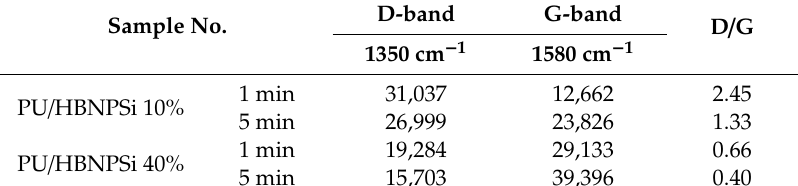
Table 3. The area ratio of Raman shift from PU / HBNPSi hybrid char.